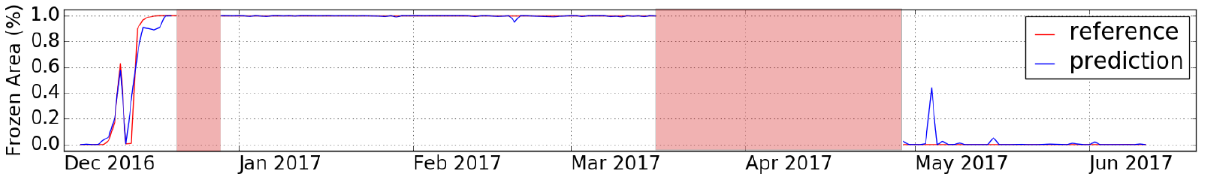
Figure 4. Predicted vs. groundtruth frozen area for Cam0. Red bars indicate periods of data gaps, where no images were stored.